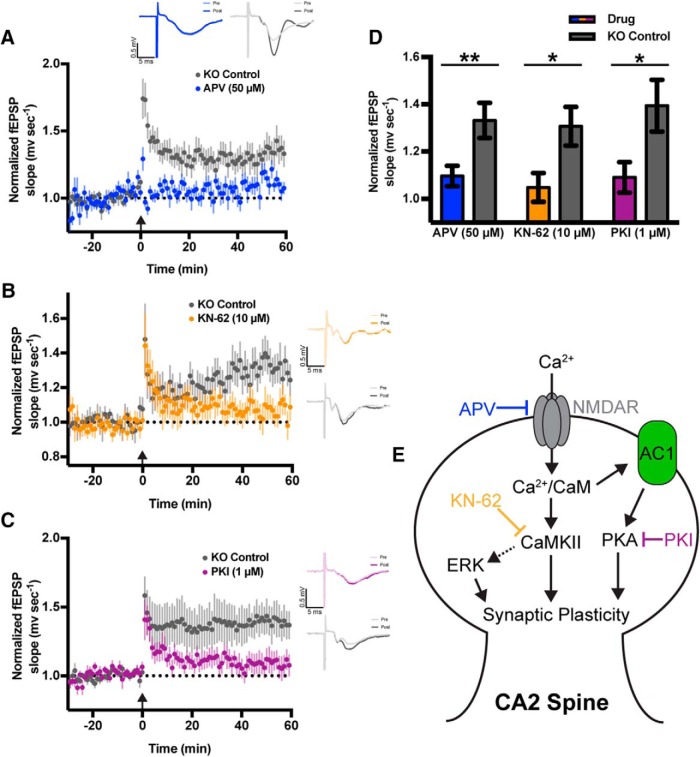
The nascent CA2 LTP in RGS14 KO mice requires Ca2+-activated pathways. A, Summary graph of LTP induction experiments performed in area CA2 of RGS14 KO (Amigo2-EGFP+) mice either in the presence (blue) or absence (gray) of bath-applied NMDA receptor antagonist APV (50 μM). LTP was induced by HFS (3 × 100 Hz) in stratum radiatum at time 0 (arrow). Data are represented as mean normalized fEPSP slope ± SEM (dotted reference line at 1.0). Insets (top) are representative traces of field potentials recorded in CA2 stratum radiatum of RGS14 KO mice before (light line) and after (heavy line) LTP induction. B, Summary graph of LTP induction experiments performed in area CA2 of RGS14 KO (Amigo2-EGFP+) mice either in the presence (yellow) or absence (gray) of bath-applied CaMK inhibitor KN-62 (10 μM). C, Summary graph of LTP induction experiments performed in area CA2 of RGS14 KO (Amigo2-EGFP+) mice either in the presence (blue) or absence (gray) of bath applied PKA inhibitor PKI (1 μM). D, Bar graph displaying the mean normalized field potential slope (mV s−1) from data shown in A–C, at 40–60 min following LTP induction with error bars representing SEM. Sample sizes (in slices/animals) are for APV: drug n = 14/10, KO control n = 13/8. For KN-62: drug n = 19/9, KO control n = 16/9. For PKI: drug n = 18/10, KO control n = 16/10. Sample sizes are the same for averaged time courses of each group in A–C. Each inhibitor was compared with paired KO CA2 controls by unpaired two-tailed t test; **, p < 0.01; *, p < 0.05. E, Signaling diagram of a CA2 spine from a RGS14 KO mouse depicting mechanistic targets of the pharmacological inhibitors used in A–C.